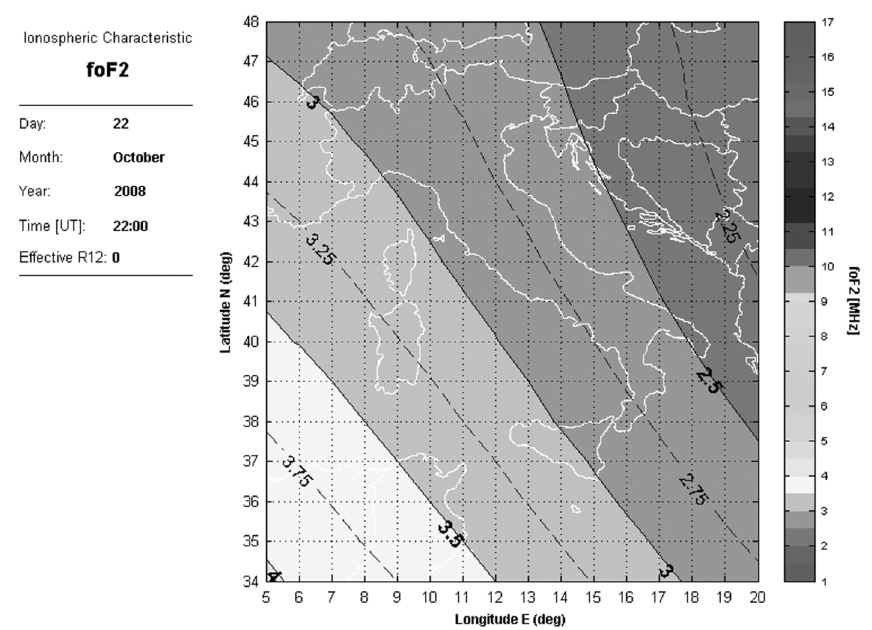
Fig. 2. Nowcasting map of foF2 obtained by SIRMUP over Italy and near Balkan